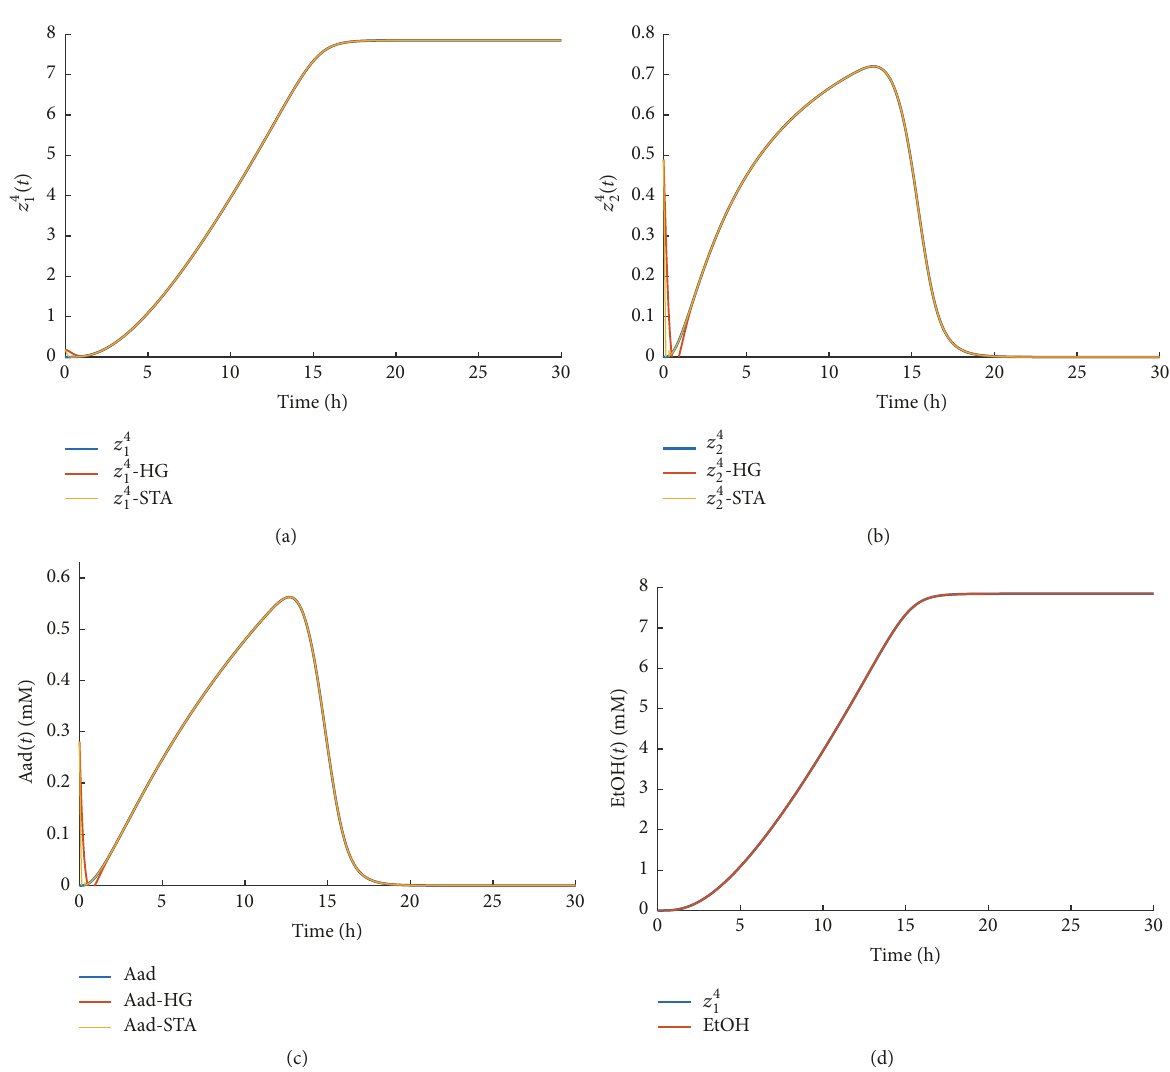
𝑧 3 𝑧 3 𝑧 3 1 , 2 , and 2 corresponding to citrate, isocitrate, and